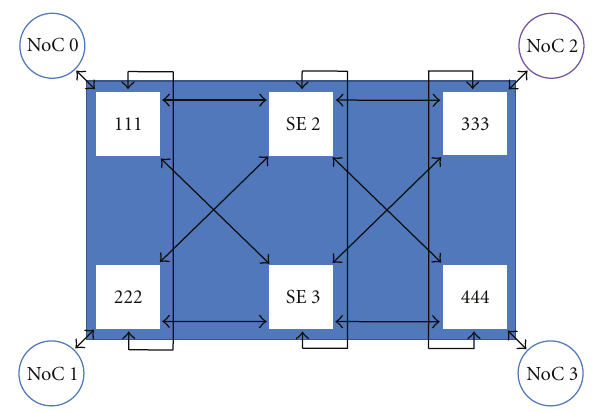
Figure 19: The simulation state of NiP-HXN model at fourth step of best case.